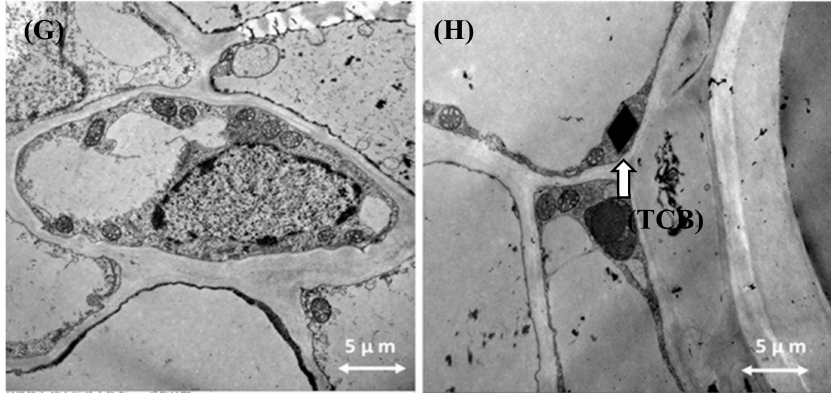
Figure 6. E ff ects of Fusarium oxysporum and Meloidogyne incognita alone and in combination on the anatomical structure of the roots of two tomato cultivars (G. maofen 802 and Zhongza 09) under TEM: ( A ) the healthy root cells of G. maofen 802; ( B ) healthy root cells of Zhongza 09 as control; ( C ) root cells of G. maofen 802 after Mi application; ( D ) root cells after Mi application in Zhongza 09 with TCB structure; ( E ) roots of G. maofen 802 after Fo + Mi application with mycelium (M) inside the cell; ( F ) root cells of Zhongza 09 after Fo and Mi application with TCB structure; ( G ) root cells of G. maofen 802 after single application with no TCB; ( H ) root cells of Zhongza 09 after single application of Fo showing unique crystalline structure near mitochondria. Note: TCB, tetra hedral crystalline bodies; M,